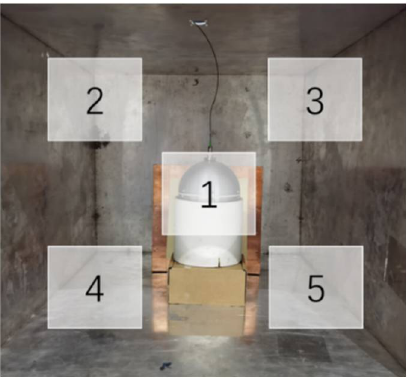
Figure 18. Schematic diagram of observation points location.